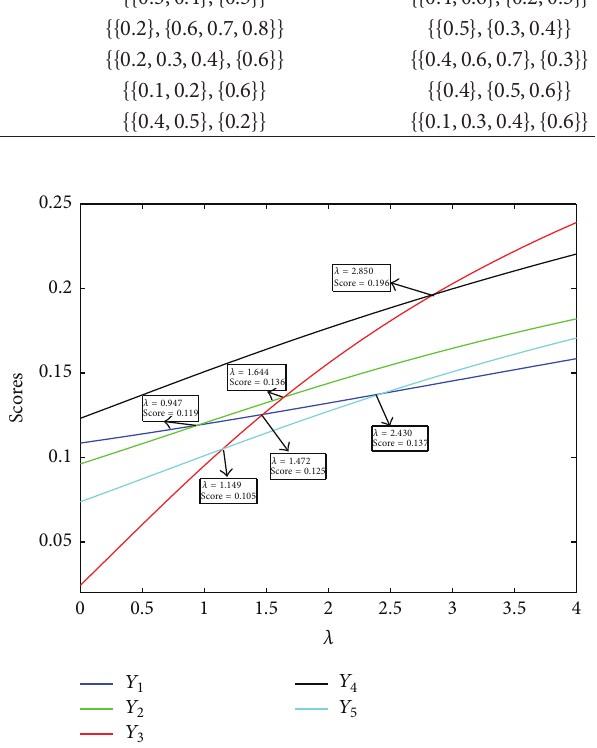
Figure 1: Scores for theses obtained by GDHFCOA